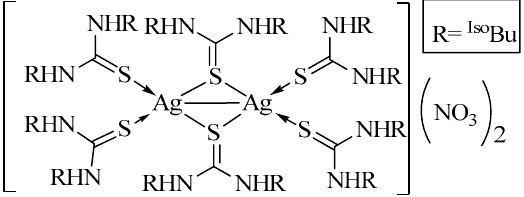
Figure 2. Dimeric silver complex, 2 . [Ag 6 L 8 Cl 4 ] (3): A solution of AgCl (0.1 g, 0.7 mmol) was mixed with 1,3-diisobutyl thiourea (0.15 g, 0.79 mmol) in acetonitrile. After overnight stirring, the solvent was al- lowed to evaporate at room temperature. The colorless needle-like crystals of 3 (Figure 3) appeared in the solution after 3 days, they were separated from the mother liquor and the structure of the complex was determined by X-ray diffraction. Figure 3. Silver cluster, 3 . 2.4. Hirshfeld Surface Analysis The Hirshfeld surfaces and 2D fingerprint plots were generated using Crystal Ex- plorer 17.50 [41]. The X-ray single-crystal crystallographic information files were used as input files. The default setting used for Hirshfeld Surface/fingerprint generation in Crystal Explorer is: property: none; resolution: High (standard). For fingerprint generation (di vs. de plot) we used; range: standard, filter: by elements and fingerprint filter options is both inside-outside elements including reciprocal contacts. The interactions with normalized contact distance in crystal structure shorter than the sum of the corresponding van der Waals radii of the atoms, are highlighted by red spots and the longer contacts with the positive d norm value are represented in blue color. 2.5. Antioxidant Assay Complexes 1 – 3 have been tested for their antioxidant activity. The DPPH free radical scavenging method has been employed to investigate representative compounds as anti- oxidant agents. When compounds donate hydrogen or electrons to the free DPPH radical, the initial absorbance of the corresponding solution decreases. These observations are taken as a key to measure radical scavenging activity. A solution of DPPH was prepared (39 mg/100 mL), absorbance was measured under normal conditions at 517 nm for blank (A o ). Specific amount of complex solution was mixed with DPPH, solutions were incu- bated in dark for 30 min at room temperature. The absorbance of each sample was meas- ured at the same wavelength, 517 nm (A Sample ). Percent inhibition (I) % of DPPH radical was calculated for the various concentrations of compounds as given below [42]. Percent Inhibition I% = (cid:3002) (cid:3116) (cid:2879)(cid:3002) (cid:3002) (cid:3116) × 100